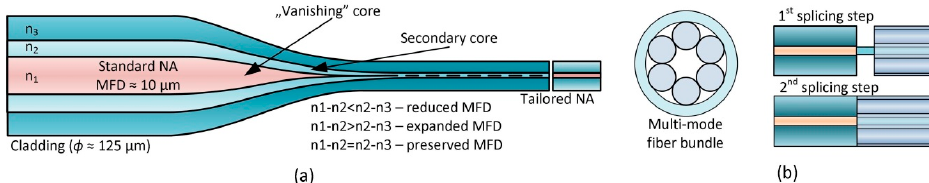
Figure 7. Cross-section of the refractive index profile along a signal fiber taper with the vanishing core technology adapted from a paper [67] ( a ); stages of (6 + 1) × 1 combiner fabrication process adapted from a paper [68]: cross-section of MM fiber bundle (left), 1st splicing step (upper right) and 2nd splicing step (bottom right) ( b